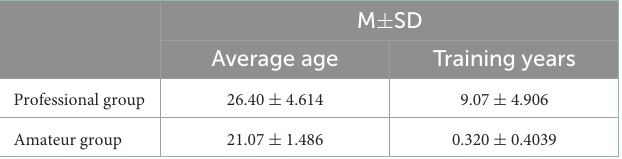
TABLE 1 Average age and average years of training of subjects in both groups (unit: age, year).